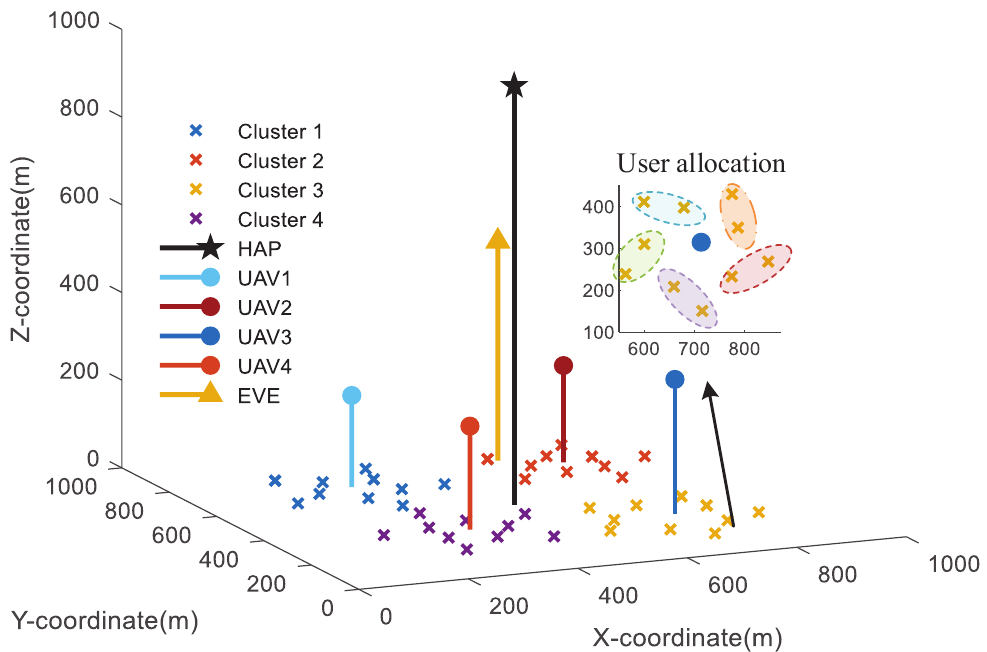
Figure 3. Optimal 3D-locations of UAVs.